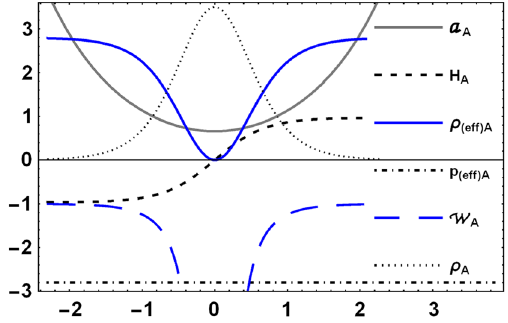
Fig. 1 Different cosmological quantities related to the model A which are characterized by solution (28). The black solid line indicates the scale factor. The black middle sized dashed line shows the Hubble parameter, the solid blue curve indicates the effective energy density, the black dot-dashed curve shows the pressure, The long-dashed blue curve shows the effective EoS and the black dotted curve shows the effective energy density. We see that W A < − 1 always, signaling that the scalar representation of model A should be defined by a phantom field. We have set w = 0 . 6, ρ 0 = 1, P = − 2 . 8 and a 0 = 1 . 12 . The horizontal axis represents the cosmic